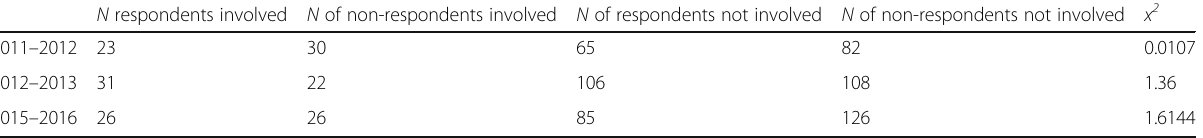
Table 3 Comparison of respondents and